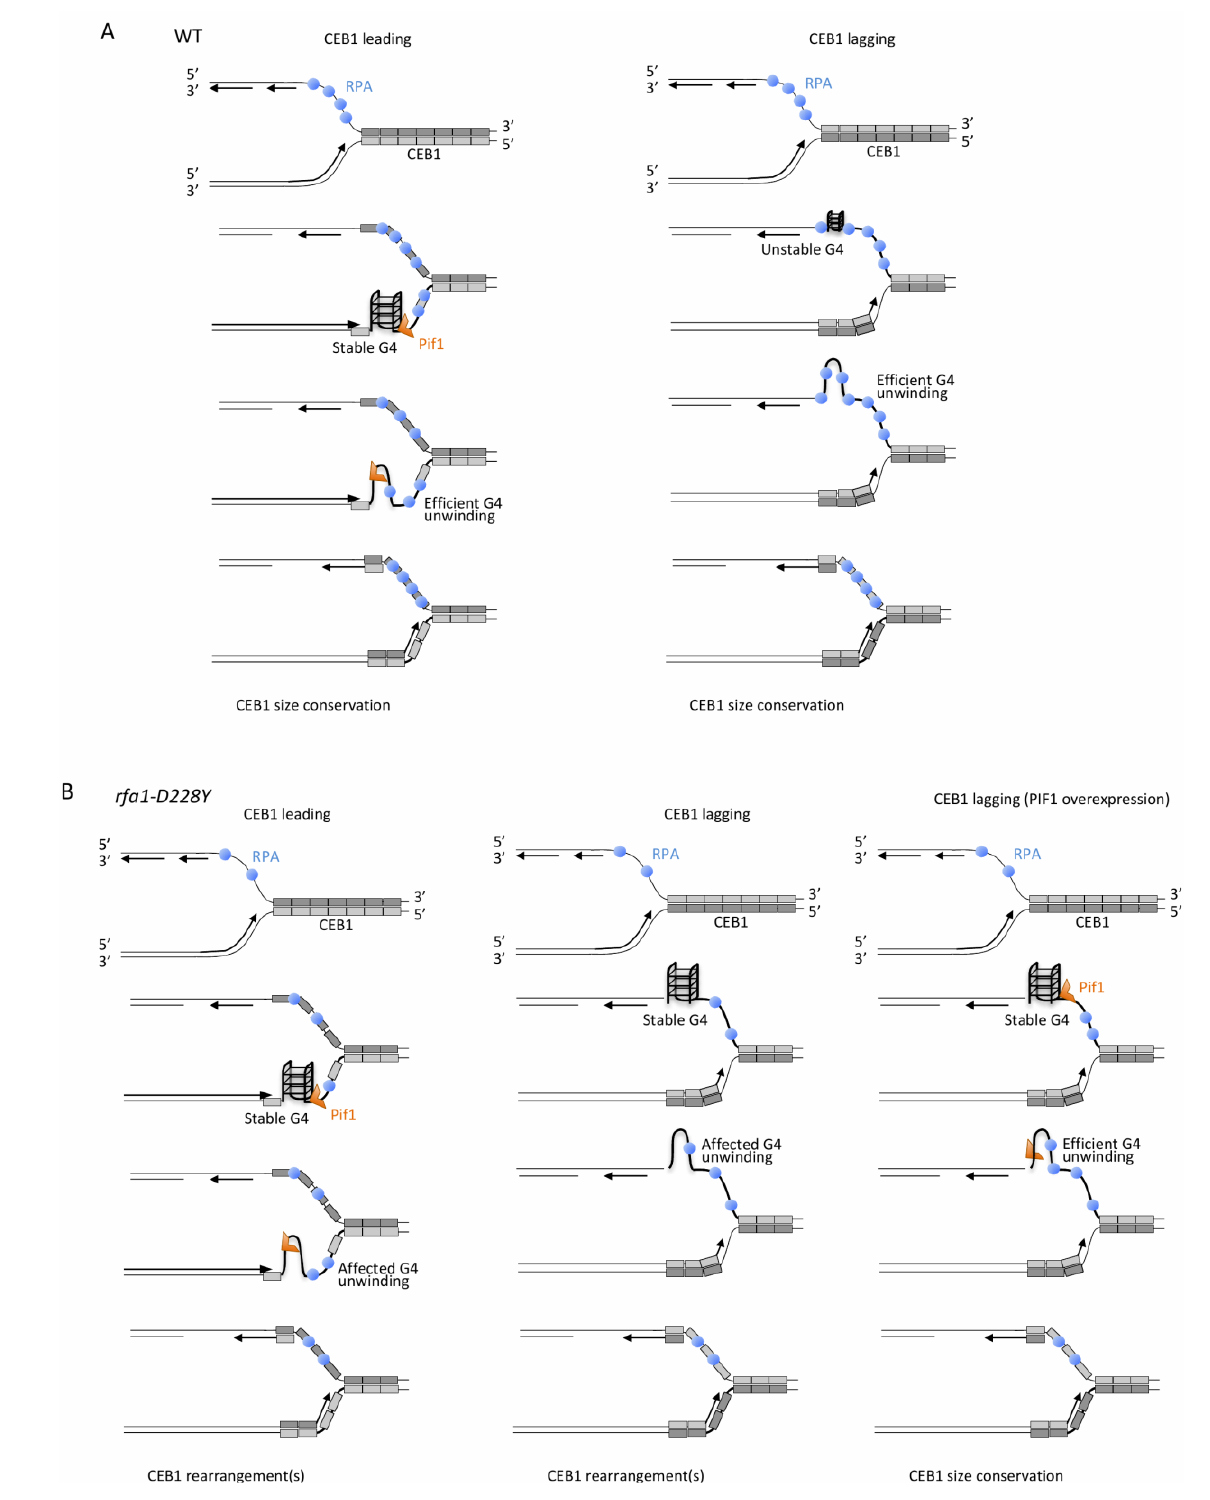
FIGURE 8: Mechanistic model for the unfolding of CEB1-G-rich structures by RPA and Pif1. ( A ) In WT cells, when the G-rich strand (light grey) is on leading strand (left part, CEB1 leading), stable G-quadruplexes structures are efficiently removed by Pif1, as proposed by Lopes and colleagues [33]. At the leading strand, RPA may cooperate with Pif1 either by preventing the refolding of the G4 structure or by recruiting Pif1 to the leading strand. When the G-rich strand (light grey) is replicated by the lagging polymerase (right part, CEB1 lagging) binding of RPA to the G-rich strand prevents formation of stable G-rich secondary structures. In this context, Pif1 is dispensable. ( B ) In the rfa1-D228Y mutant, at the leading strand (left part), the reduced affini- ty of RPA for G-rich ssDNA either reduce the ability of RPA to prevent the refolding of the G4 structure or decrease Pif1 recruitment. The decrease in RPA affects G4-unwinding and leads to the formation of CEB1 rearrangements. At the lagging strand (middle part), the decrease affinity of RPA for G- rich ssDNA facilitates the formation of stable G-rich structures, affects their unwinding, and generates CEB1 instability. In such a case, overexpression of Pif1 (right part) can efficiently unwind G-rich structures, leading to CEB1 size